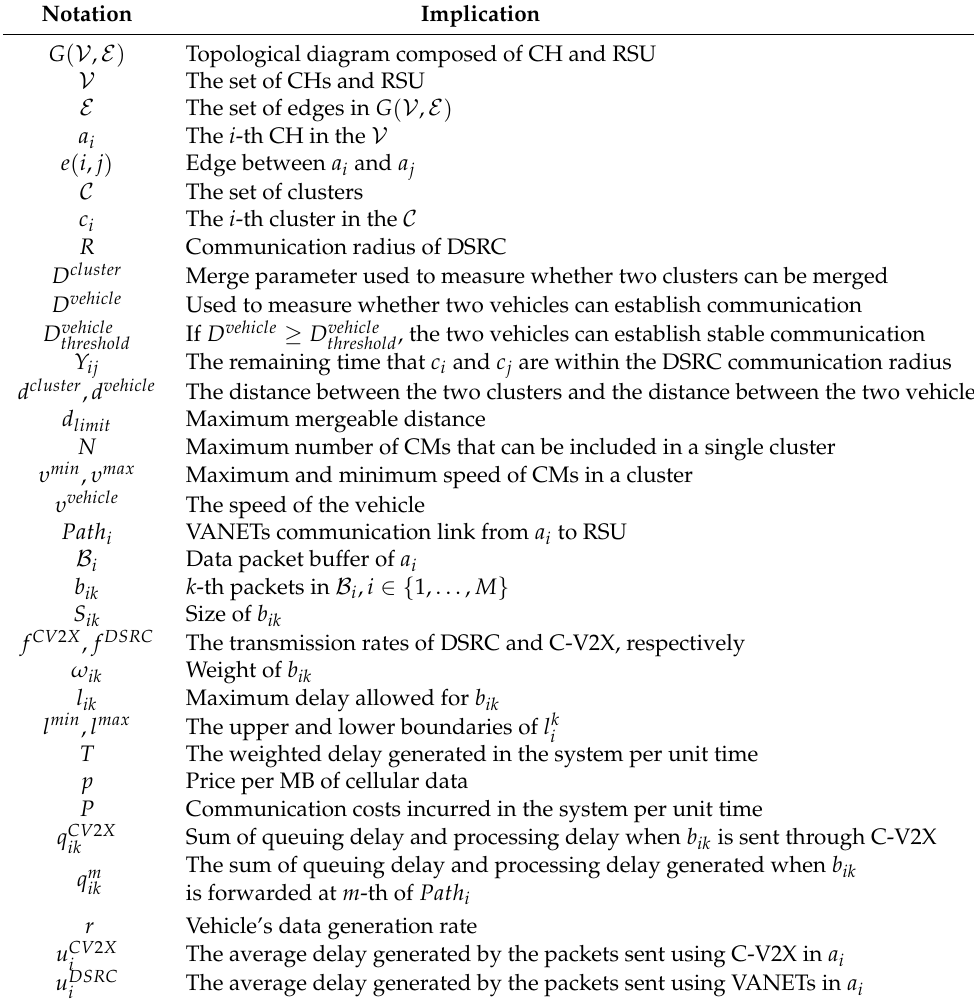
Table 2. Notation